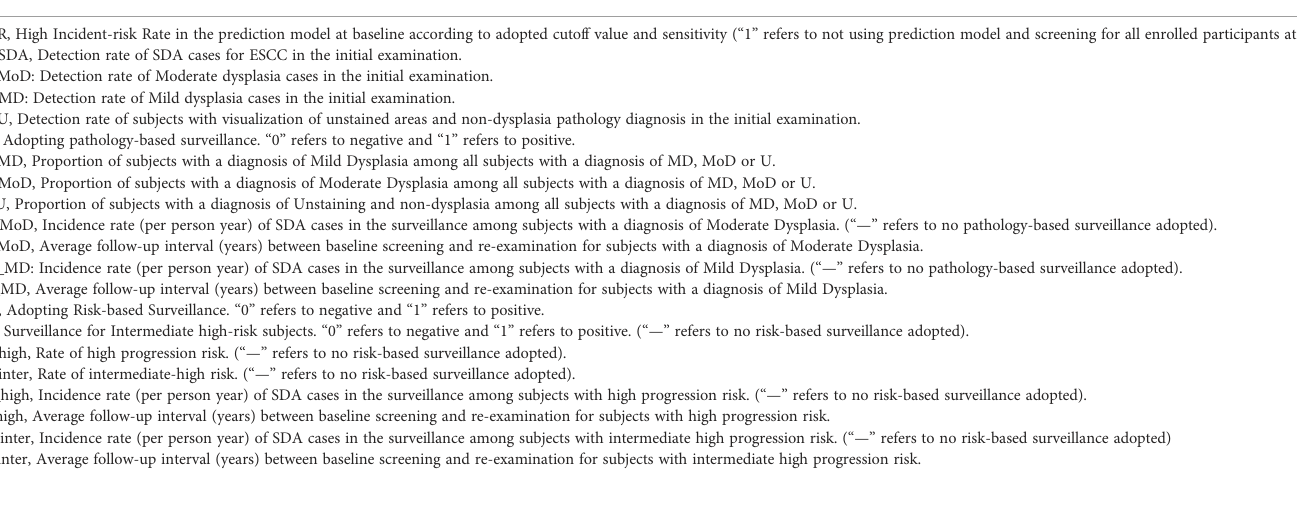
TABLE 1 Age-strati fi ed parameters and reference sources of two-step precision screening strategies in the decision tree model for esophageal cancer screening in high-risk areas of China. Age Strategy <60 Traditional <60 <60 <60 Precision 3 <60 Precision4 ≥ 60 Traditional ≥